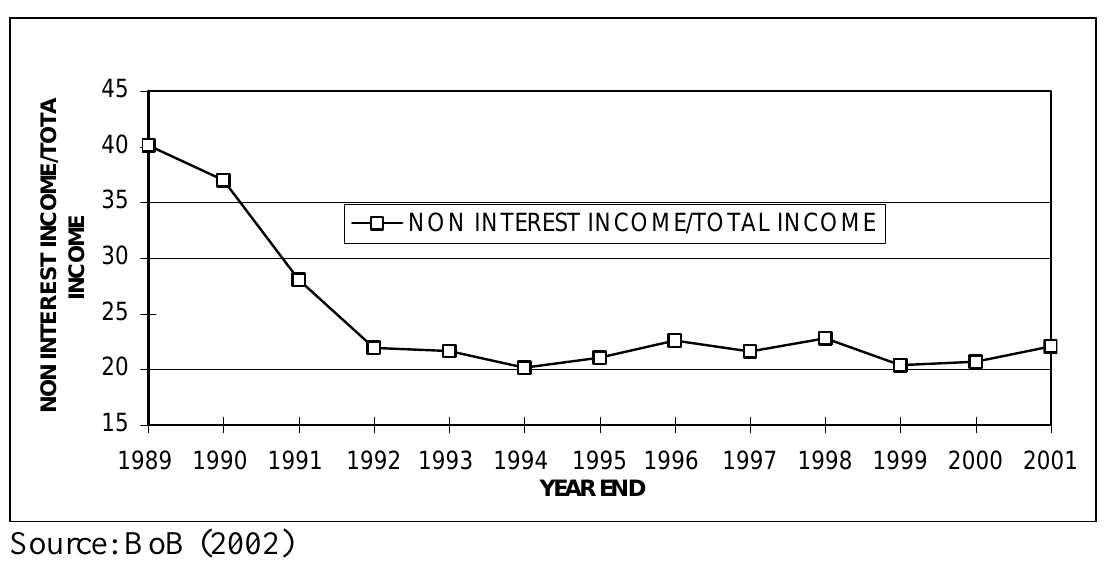
Ratio of non-interest income to total assets, 1989-2001